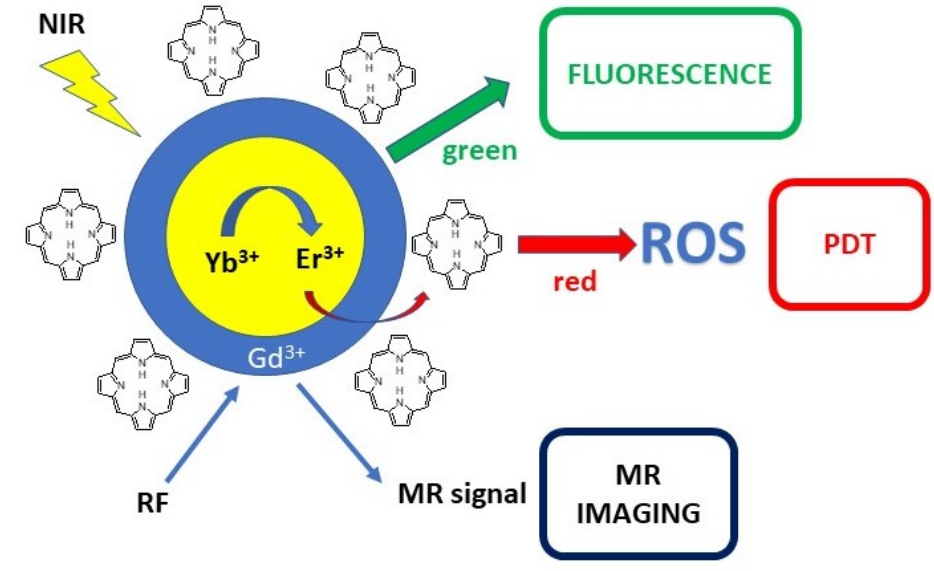
Figure 6. Schematic presentation of energy transfer in UNs–Ce6 conjugates.